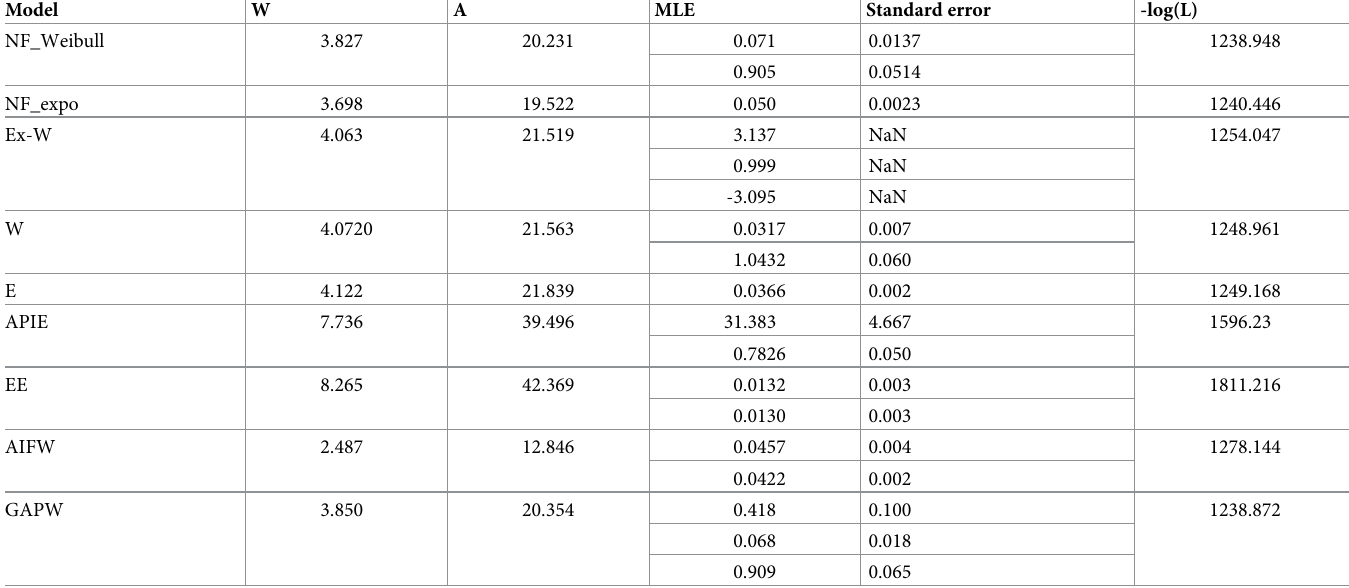
Table 7. MLE and standard errors for Covid-19 data of Afghanistan. Model